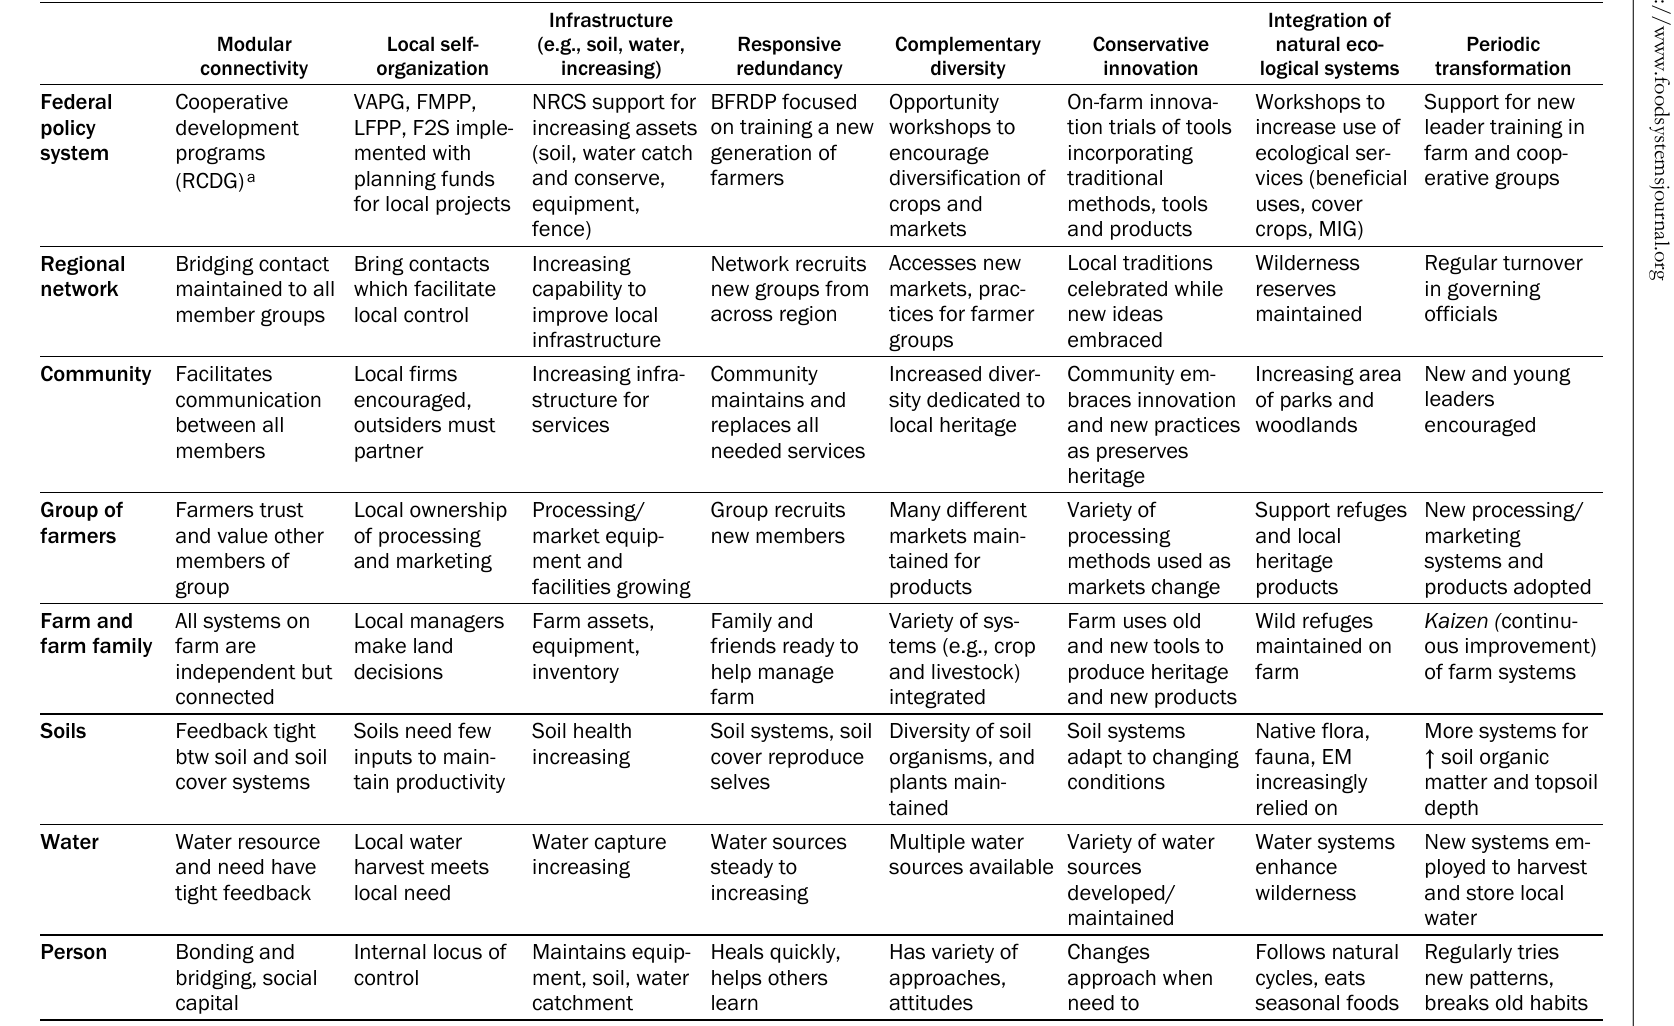
Table 2. Resilient Food Systems Three-dimensional Matrix: Scale, Qualities,